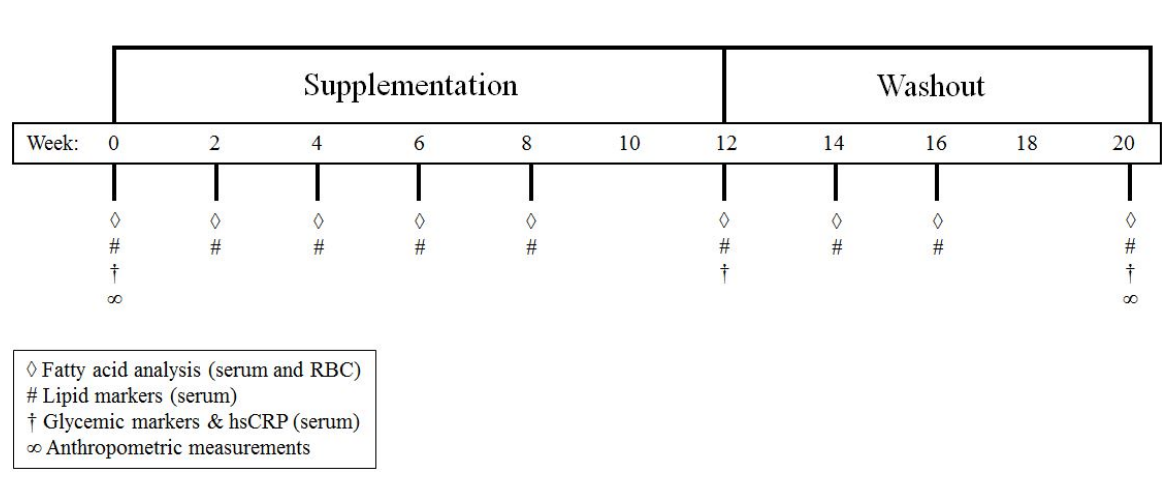
Figure 1. Study timeline and experimental design. The supplementation period lasted for 12 weeks and the washout period for 8 weeks (total duration of 20 weeks). Symbols indicate which measurements were taken at each